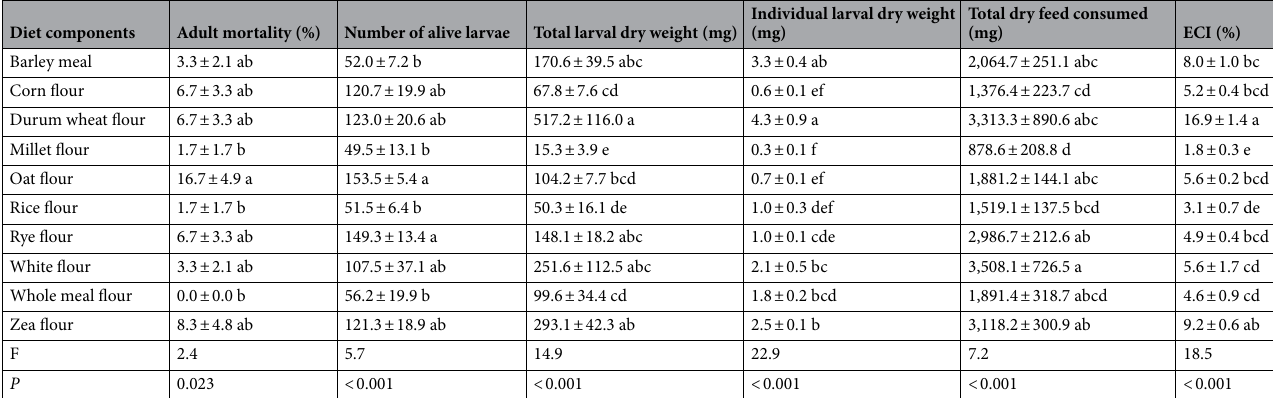
Table 3. Adult mortality (%) (after 1-week), number of alive larvae, total larval dry weight (mg), mean individual larval dry weight, total dry feed consumed (mg), and efficiency of ingested food conversion (ECI, %) of Tenebrio molitor larvae fed on different cereal flours for 10 weeks. In all cases, values represent means ± SEM (n = 6). Within each column, means followed by the same lowercase letter are not significantly different (in all cases df = 9, 59; Tukey–Kramer HSD test at P = 0.05).